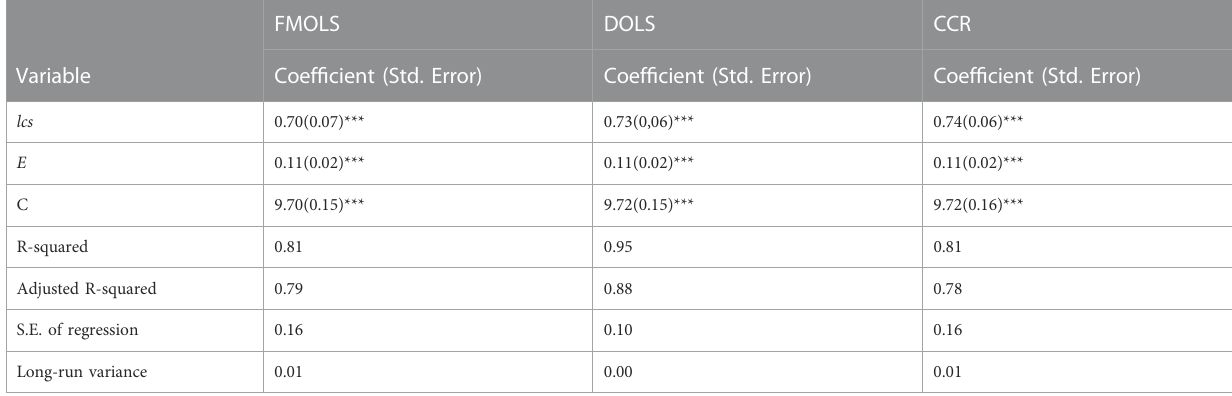
TABLE 5 Long-run estimation results using FMOLS and